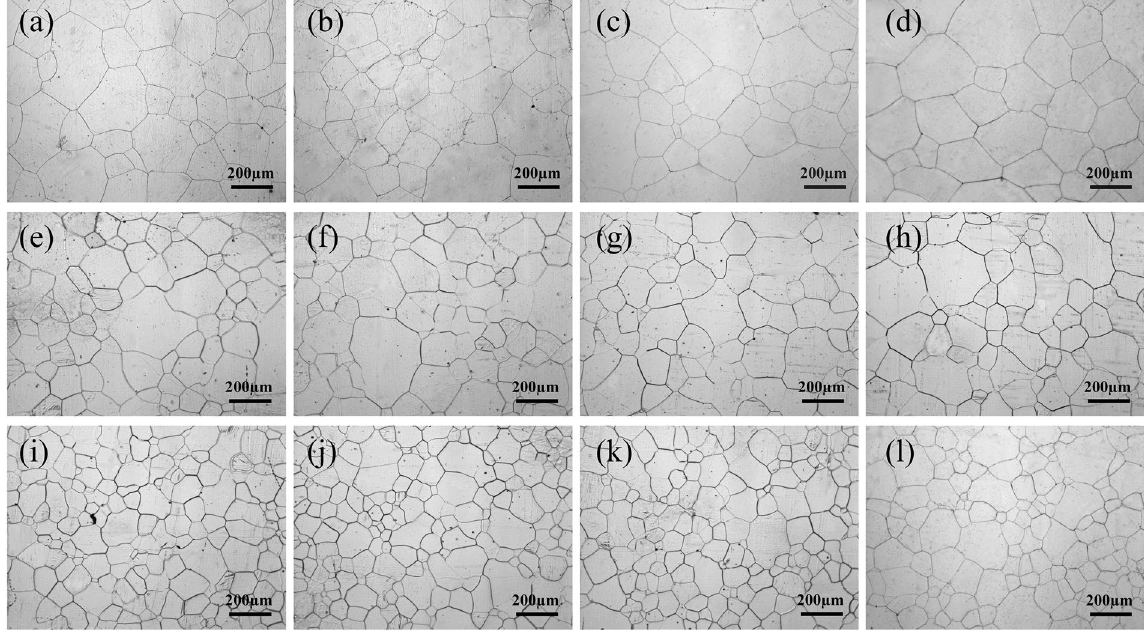
Figure 3. Optical microscopy images of Mg-3Sn alloy microstructures: ( a ) unrolled and subjected to solution treatment at 480 °C for 24 h, ( b ) further aged at 170 °C for 10 h, ( c ) 35 h, and ( d ) 60 h; ( e ) as-rolled (20%) and subjected to solution treatment at 480 °C for 24 h, ( f ) further aged at 170 °C for 10 h, ( g ) 35 h, and ( h ) 60 h; and ( i ) as-rolled (50%) and subjected to solution treatment at 480 °C for 24 h, ( j ) further aged at 170 °C for 10 h, ( k ) 35 h, and ( l ) 60 h.